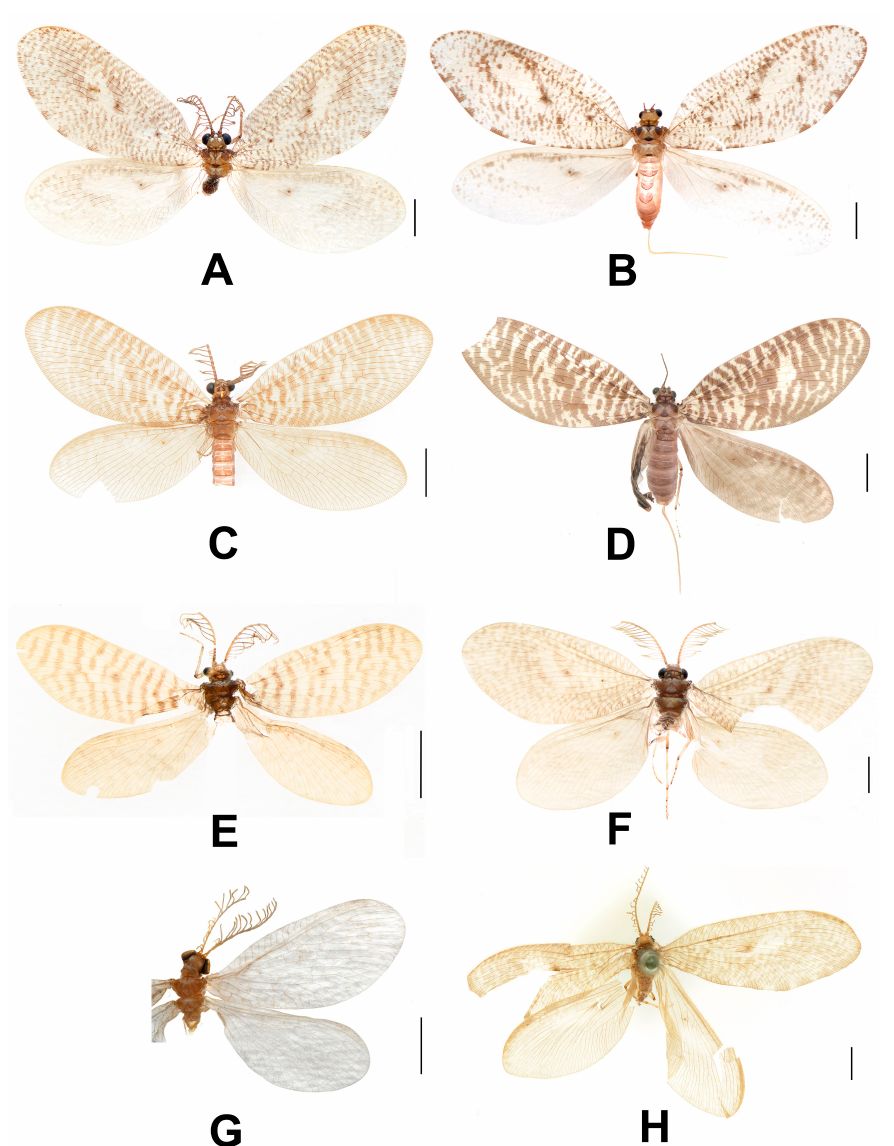
Figure 1. Adults of Dilar spp. ( A ) Dilar cangyuanensis sp. nov., male holotype; ( B ) Dilar cangyuanensis sp. nov., female; ( C ) Dilar daweishanensis sp. nov., male holotype; ( D ) Dilar daweishanensis sp. nov., female; ( E ) Dilar forcipatus sp. nov., male holotype; ( F ) Dilar laoticus sp. nov., male holotype; ( G ) Dilar malickyi sp. nov., male holotype; ( H ) Dilar nujianganus sp. nov., male holotype. Scale bars: 2.0 mm. Description. Male. Body length 3.8 mm; forewing length 10.2 mm, hindwing length 8.6